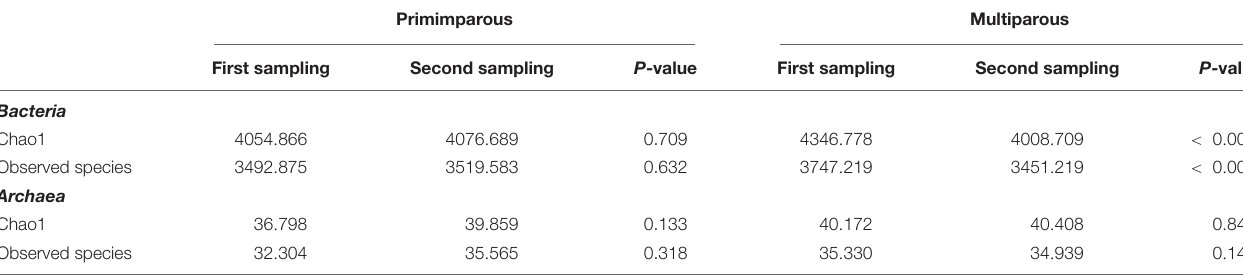
TABLE 1 | Comparison of alpha diversity index in primiparous and multiparous cows between samplings.